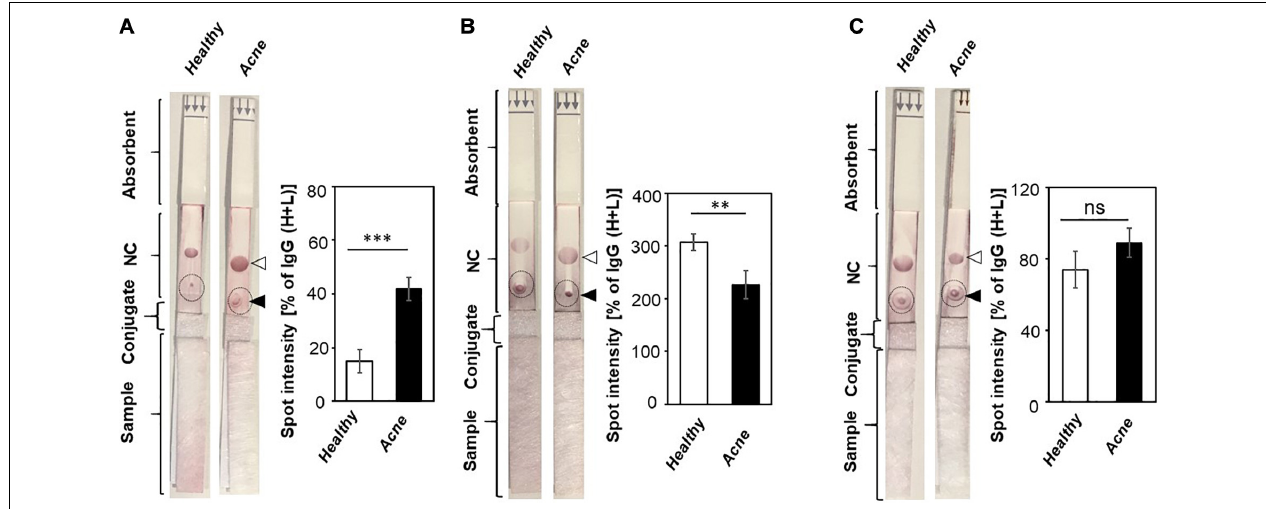
FIGURE 3 | Detection of antibodies to C. acnes , S. aureus , and C. aurimucosum in acne patients and healthy subjects. The lysates (3 µ g) of (A) C. acnes ATCC 6919, (B) S. aureus 113 (ATCC 35556), or (C) C. aurimucosum (ATCC 700975) were spotted on the test lines (solid triangle), and anti–human IgG (H+L) (open triangle) was spotted on control lines of NC membranes of LFIAs. Five percent sera (200 µ L) from healthy subjects and acne patients were added into the sample pads. The high amounts of antibodies to C. acnes ATCC 6919 and low amounts of antibodies to S. aureus were detected in sera of acne patients compared to sera of healthy subjects. The intensities of IgG (H+L) spot served as 100%. The relative intensities of purple spots (circles) corresponding to the levels of antibodies were normalized by those of IgG (H+L) spots. Individual sera from three human subjects and acne patients were used. p < 0.01 ( ∗∗ ) and p < 0.001 ( ∗∗∗ ) with mean ± SD were calculated from three healthy subjects and acne patients. ns, not significant.